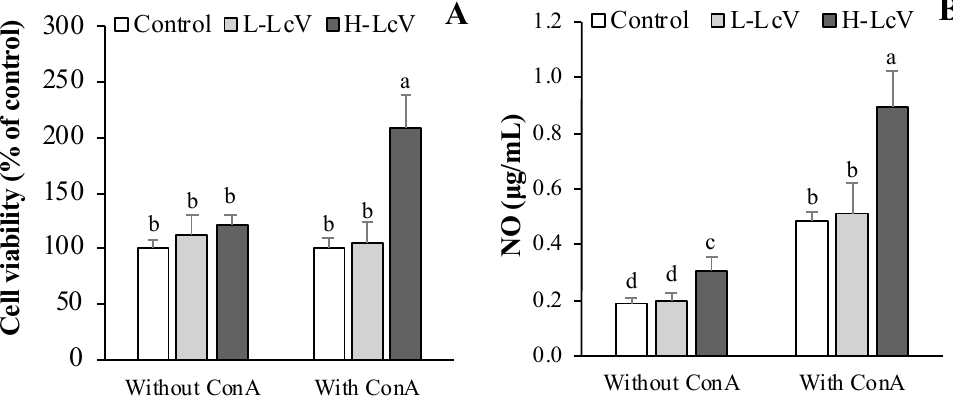
Figure 3. Splenocyte ( A ) proliferation and ( B ) NO production of mice administered with Ll. curvatus - derived ECVs (LcV) for 10 days. LcV orally treated for 10 days (once/day) at the concentration of 0.1 mg/kg BW (L-LcV) and 1 mg/kg BW (H-LcV). Isolated splenocyte were stimulated with mitogen (ConA) for 24 h or 48 h. Values are expressed as the mean ± SD ( n = 6) and followed by different letters (a–d) within a property are significantly different ( p < 0.05) according to Duncan’s multiple range test.